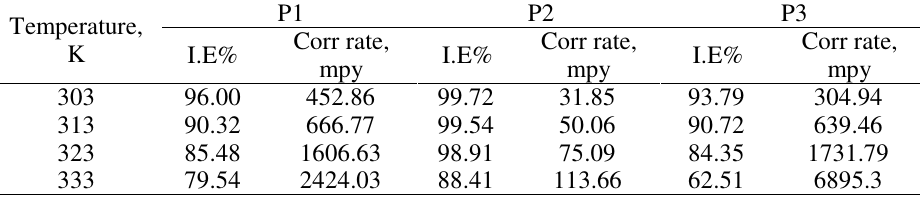
Table 2. Inhibition efficiency (%) of 1 mM concentration of inhibitors and corrosion rate of mild steel in corrosion in 1 M H